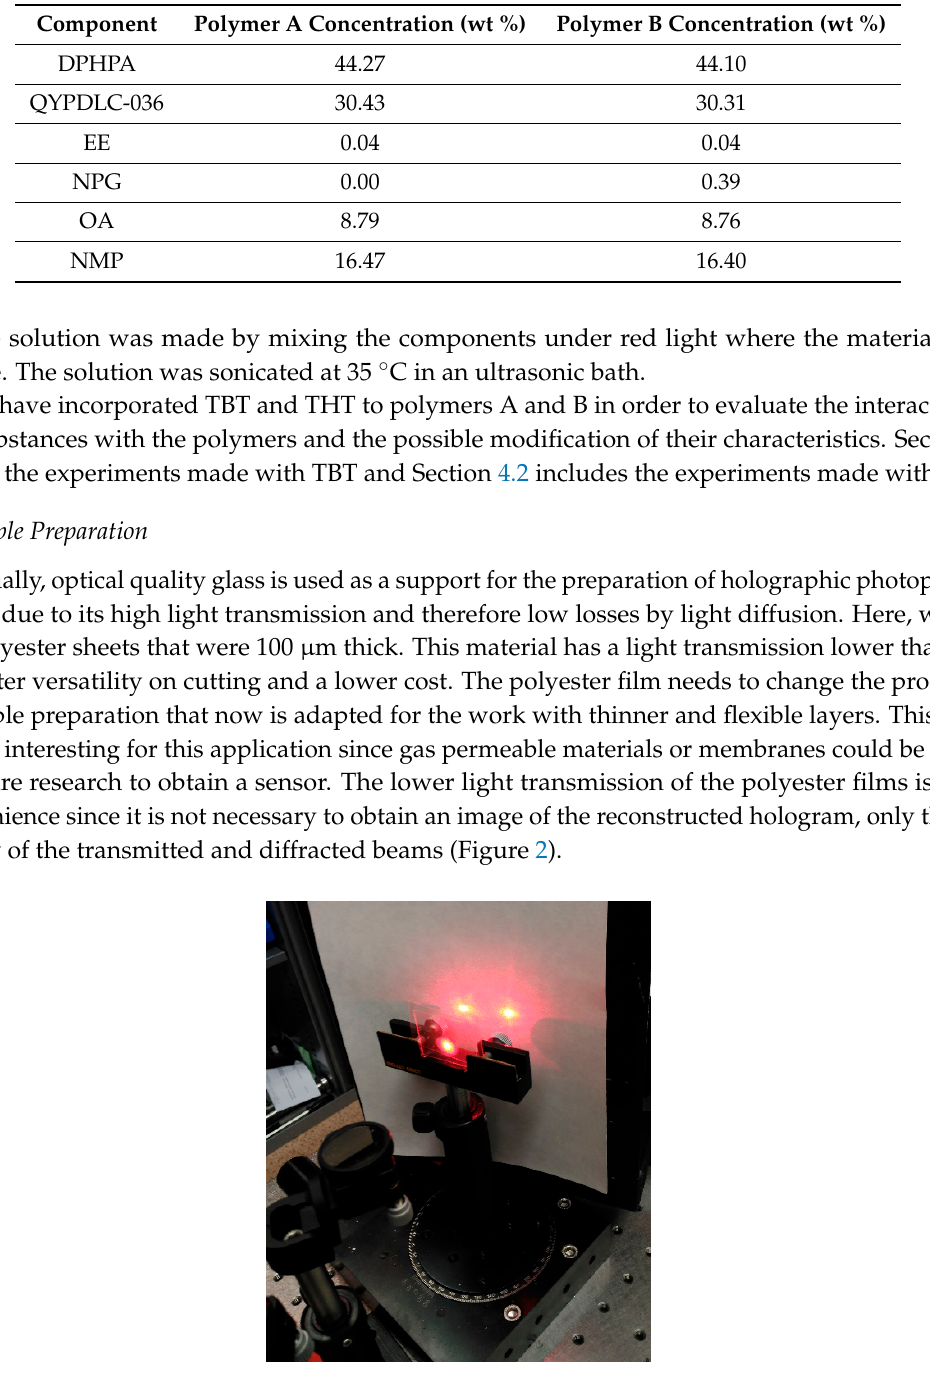
Figure 2. Beams of light diffracted and transmitted by the hologram and diffused light mainly due to the polyester layers.